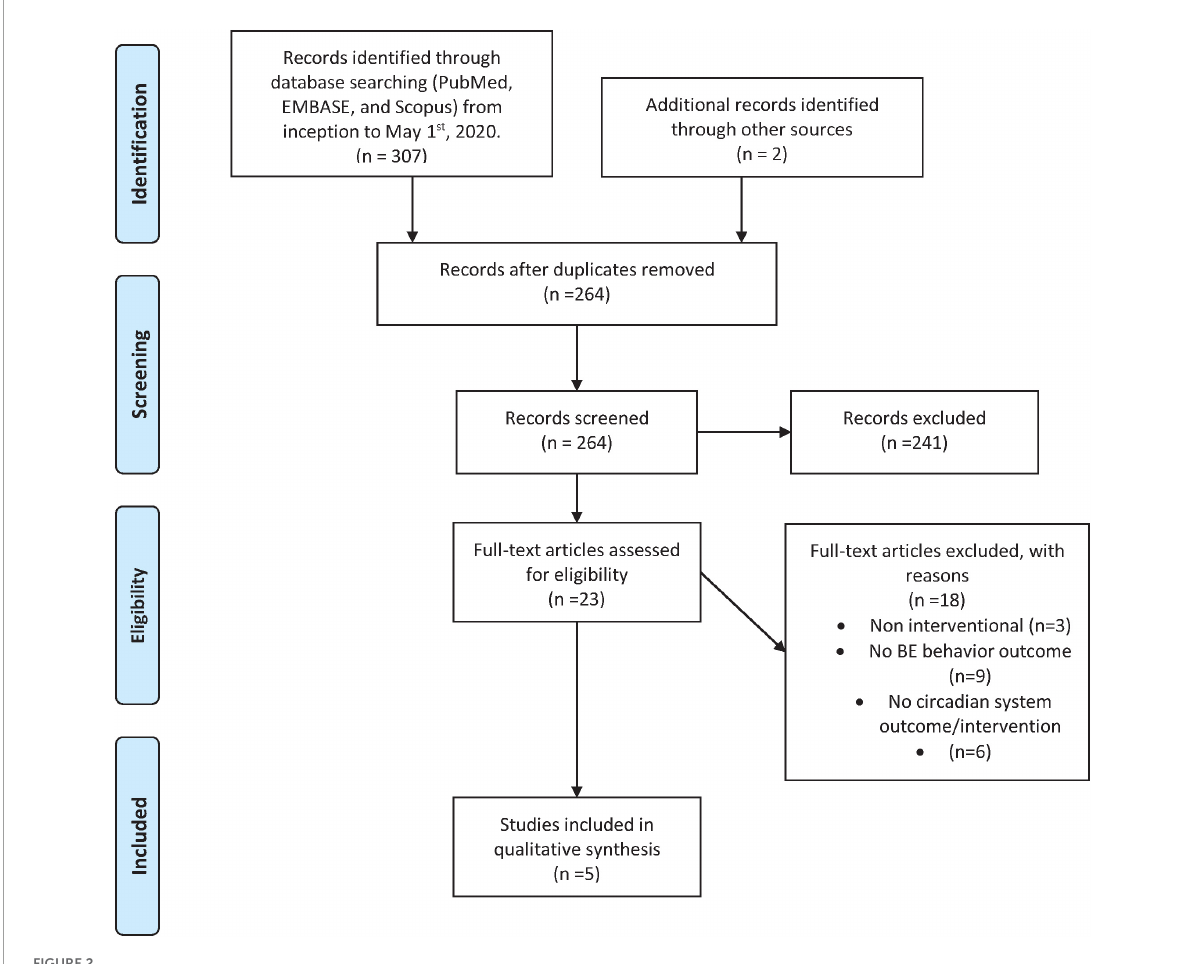
FIGURE2 PRISMA flowchart for interventional